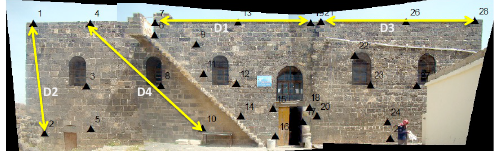
Figure 12. Orthophoto of the Western gate (Agisoft, 2018)